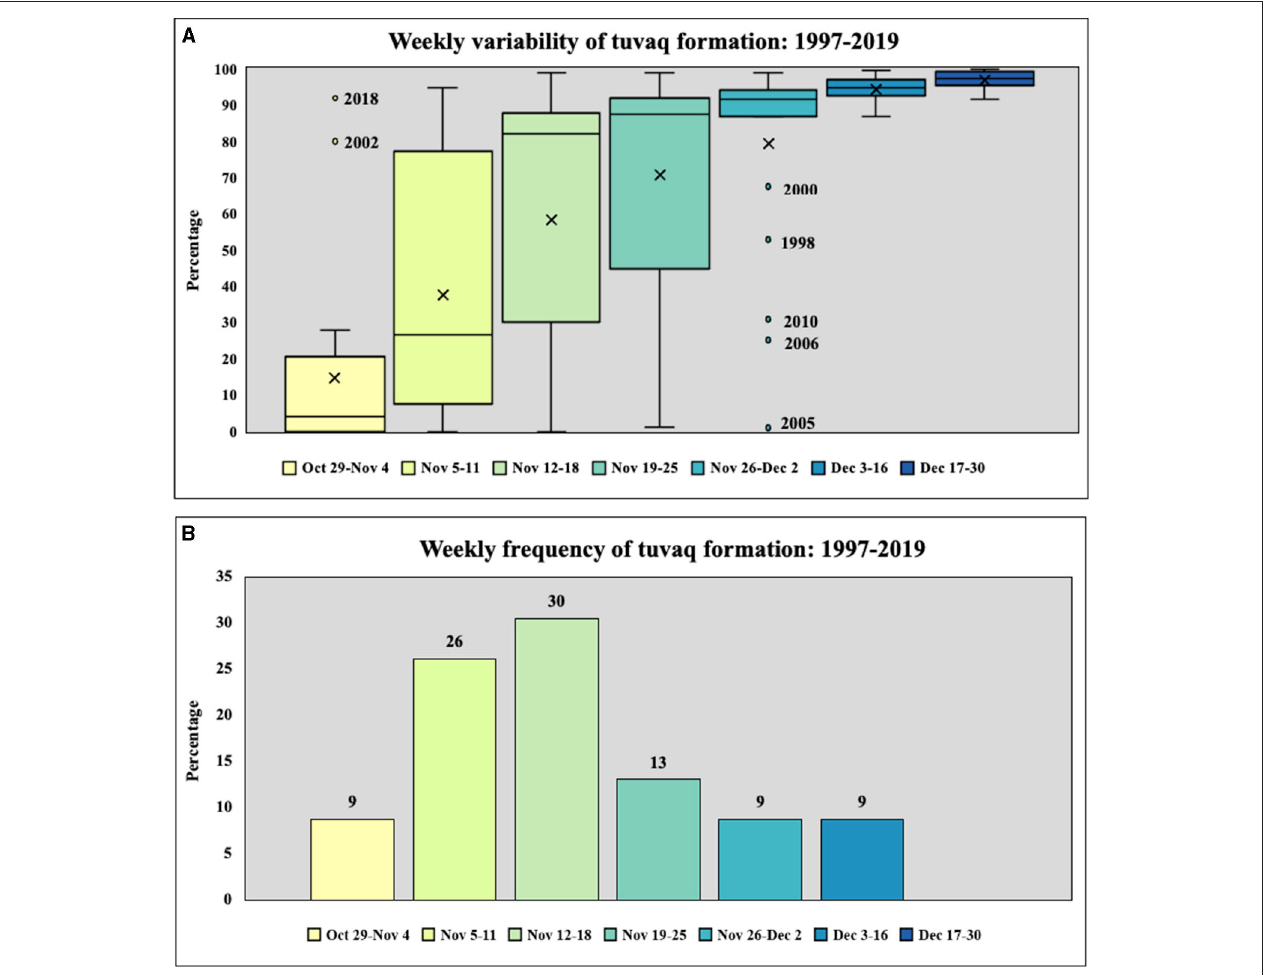
FIGURE 7 | (A) Summary graph of the weekly variability in tuvaq formation for freeze-up, 1997–2019. The box outlines the interquartile range, the average range in the variability of tuvaq formation for a particular week over the 23-year period (1997–2019). The line through the box is the median and the X denotes the mean. The vertical “whisker” lines show the minimum and maximum values. The dots correspond to outliers, or years with unusual tuvaq percentages. (B) Weekly frequency of tuvaq formation,